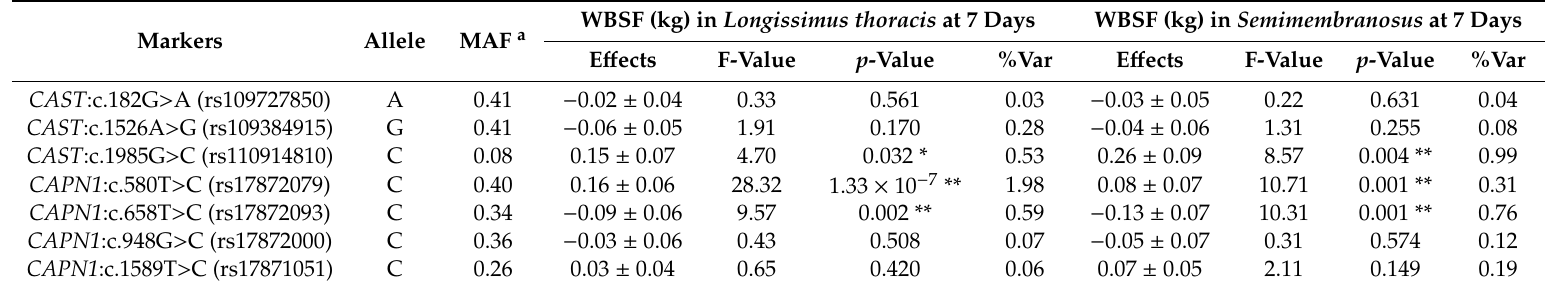
Table 2. Association of CAST / CAPN1 SNP alleles on WBSF measurements for two di ff erent muscle